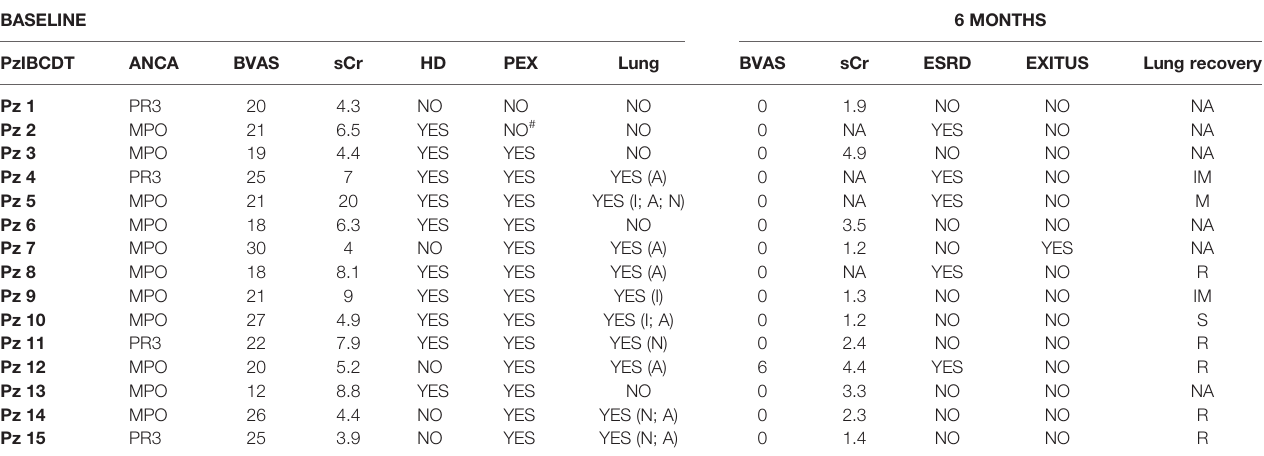
TABLE 2 | Case group parameters at baseline before and after 6 months of IBCDT.